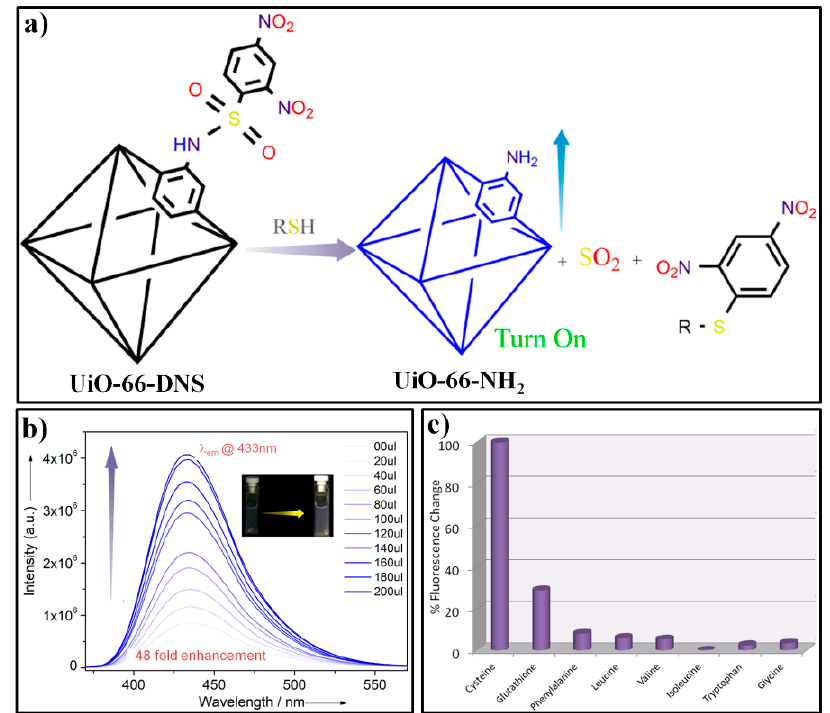
Figure 9. ( a ) The fluorescence detection mechanism of UiO-66-DNS for biothiols. ( b ) The fluorescence responses of UiO-66-DNS after addition of different amount of Cys. ( c ) Relative changes in the fluorescence intensity of UiO-66-DNS upon treatment with various amino acids. Reproduced with permission from [99]. Copyright American Chemical Society, 2016.